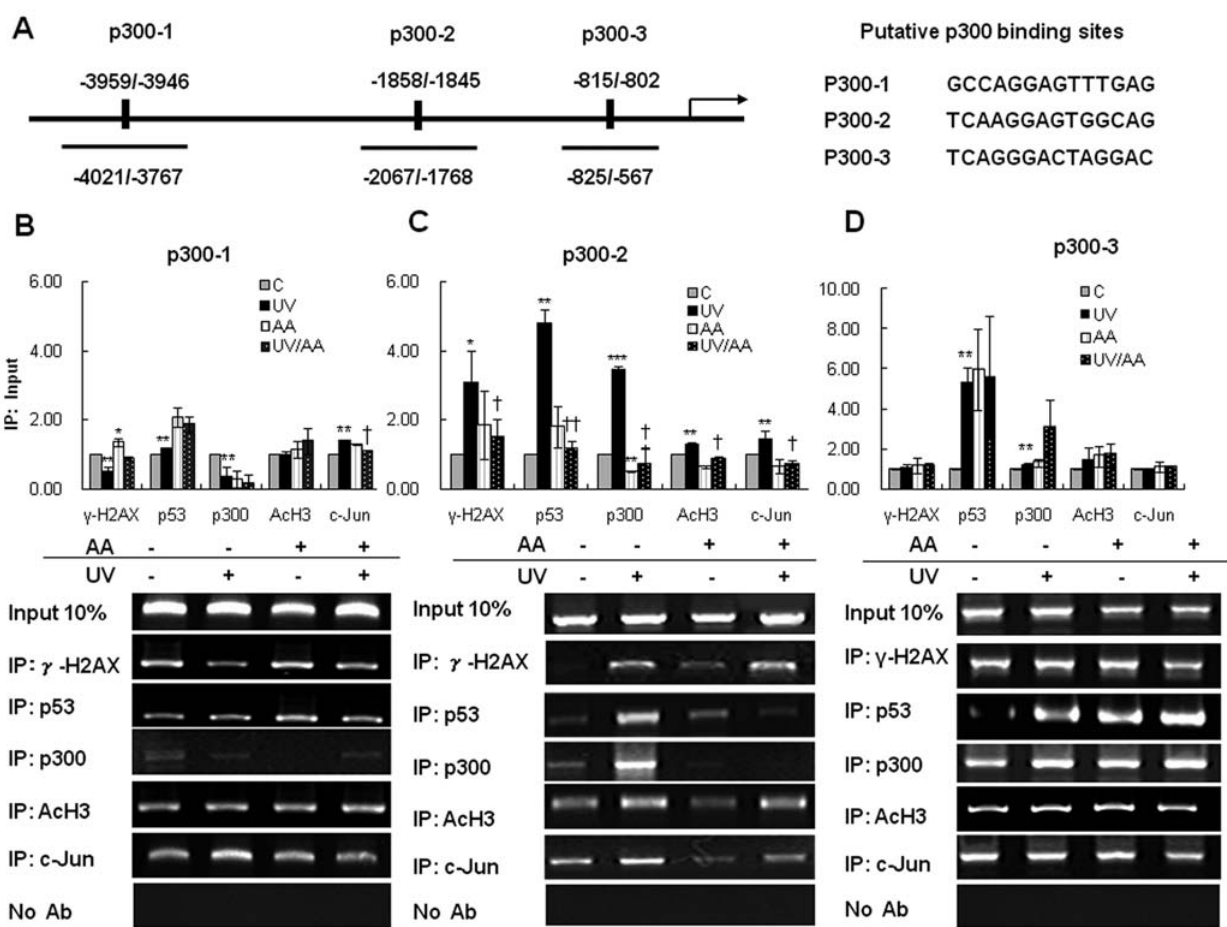
Figure 6. Regulatory elements in the human MMP-1 promoter region. A, Schematic of the MMP-1 promoter. The numbers indicate nucleotide positions relative to the translation start site. Putative p300 binding sites (p300-1, p300-2, p300-3) in the MMP-1 promoter are indicated. HDFs were UV-irradiated and post-treated with 7.5 m M AA for 6 h. HDFs were treated with 37% formaldehyde to cross-link proteins to DNA. The DNA fragments were immunoprecipitated using anti- c -H2AX, anti-p53, anti-p300, anti-acetyl-H3 or anti-c-Jun antibodies, and MMP-1 promoter fragments were detected using PCR. PCR was performed to amplify the regions between 2 4021/ 2 3767 for p300-1 (B), 2 2067/ 2 1768 for p300-2 (C) and 2 825/ 2 567 for p300-3 (D) of the MMP-1 gene. Band intensity obtained after IP was normalized to input control to show relative recruitment of c -H2AX, p53, p300, acetyl-H3 or c-Jun to the MMP-1 promoter in HDFs ( lower panels ). Bar graphs ( upper panels ) show quantitative analyses of scanning densitometric values. Values are normalized by input DNA. PCR bands are representative of three separate chromatin immunoprecipitations. Results are expressed as the mean 6 SEM fold-induction vs. basal levels. C: control, UV: UV-irradiated cells, AA: AA treated cells, UV/AA: UV irradiated cells incubated with AA. *P , 0.05, **P , 0.01 ***P , 0.001 vs. control. { P , 0.05, {{ P , 0.01 vs. UV. { P , 0.05, {{ P , 0.01 vs.